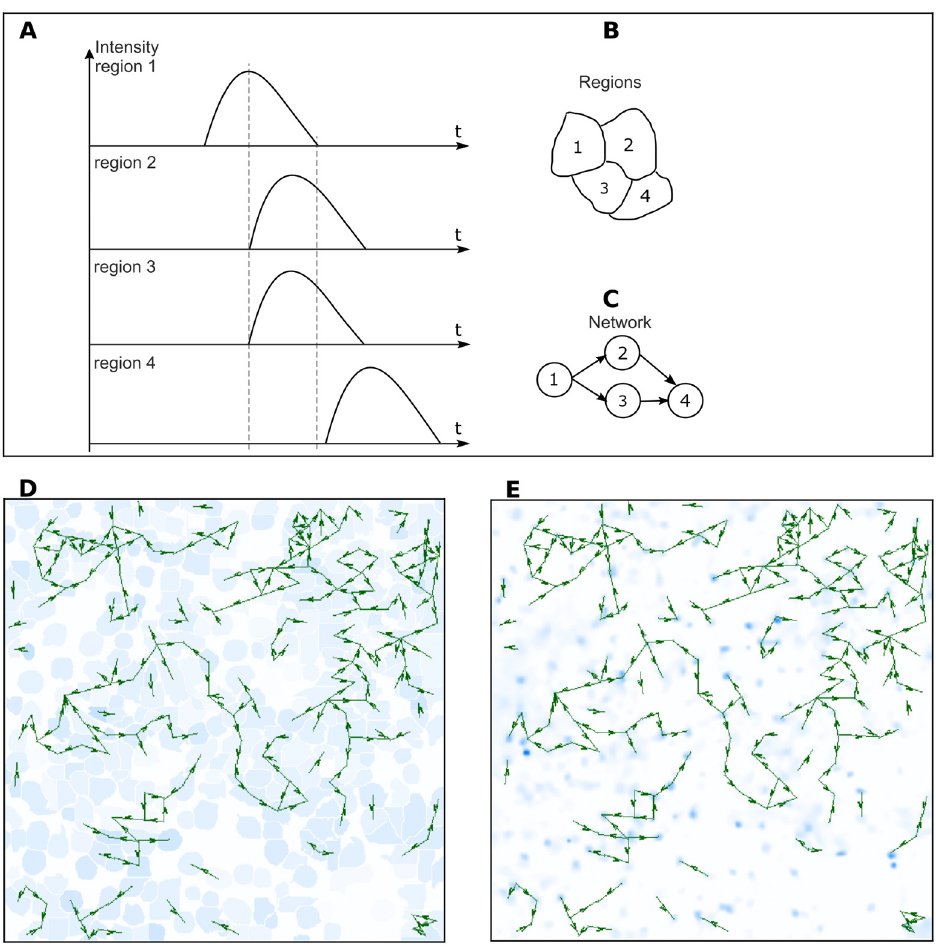
Figure 3. ( A ) Diagrams of intensity signals in four adjacent regions. ( B ) Mutual arrangement of these regions. ( C ) Resulting graph. The signal propagates from cell 1 to cells 2 and 3, and from cell 3 to cell 4. ( D ) An example of a video sequence frame formed during the visualization of the resulting dynamic graph. ( E ) The noise-filtered original video sequence obtained from a microscope with a light blue color